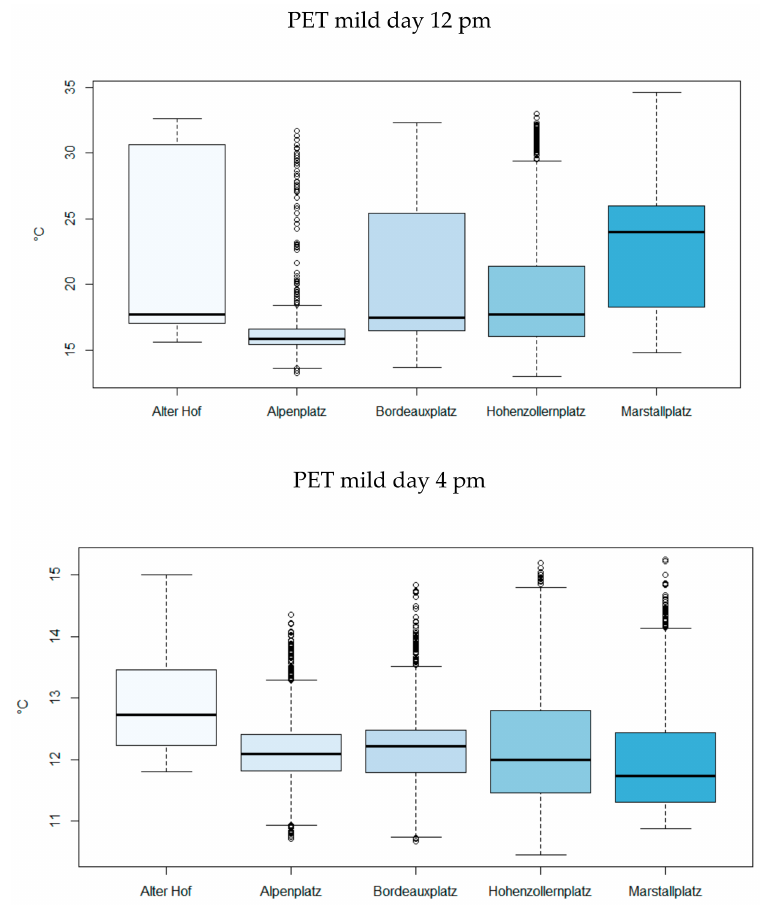
Figure 15. PET values for mild day 12 pm and 4